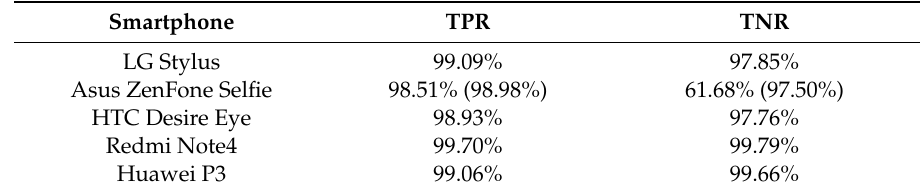
Table 3. TPR and TNR of the 2 s ANN classifier of di ff erent smartphones using the LG classifier model. The TPR and TNR of the Asus ZenFone Selfie using the classifier model trained using the accelerations with corresponding noise floor are also listed in the